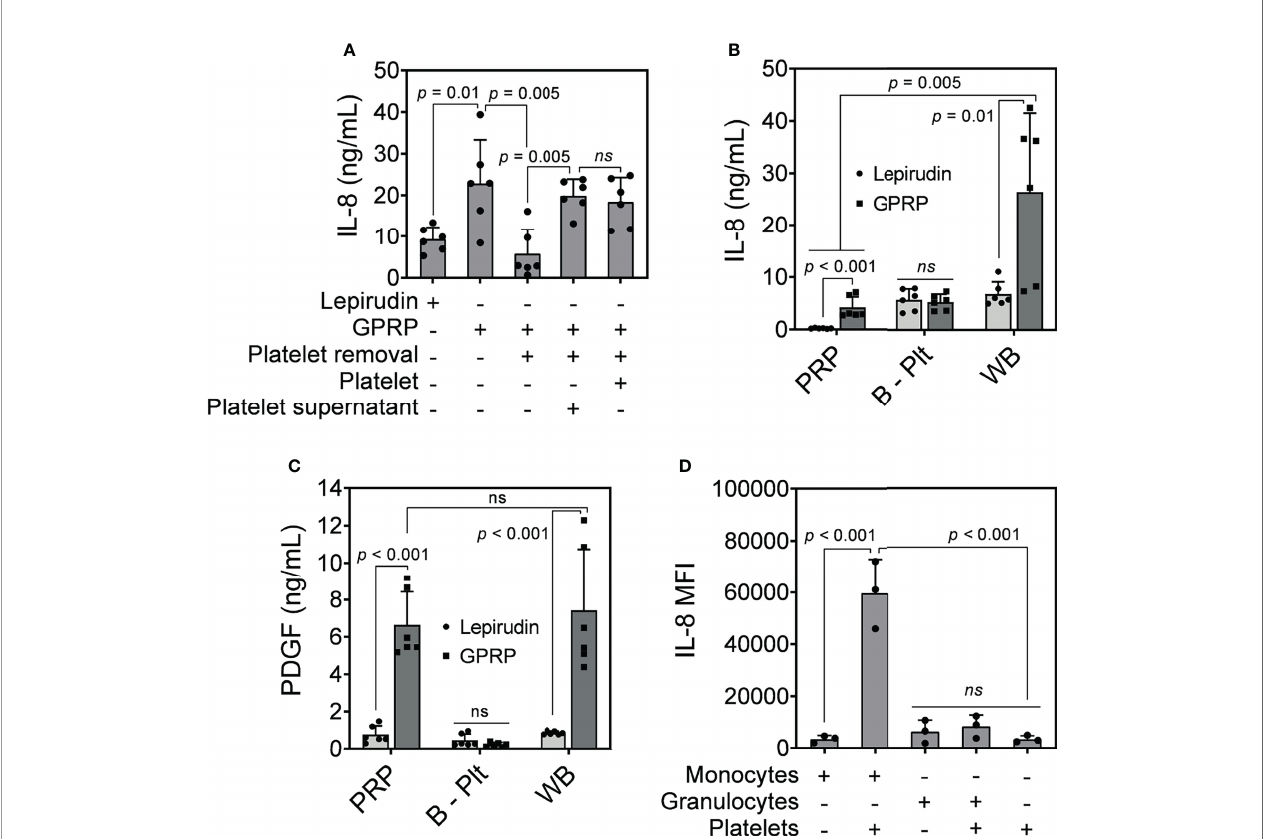
FIGURE 4 | IL-8 release in response to E. coli . (A) IL-8 was measured in GPRP-anticoagulated blood after incubation with E. coli (10 7 /ml) for 4 hours after the addition of Ca 2+ . The IL-8 levels were compared in whole blood, in platelet-depleted blood ( “ Platelet removal ” ), in platelet-plasma reconstituted ( “ Platelet ” ), and in reconstituted plasma supernatant from activated platelets ( “ Platelet supernatant ” ). (B) IL-8 and (C) PDGF measured in activated platelet-rich plasma (PRP), in platelet-depleted blood (B - Plt) and in whole blood (WB), all anticoagulated with either GPRP or lepirudin. Data are presented as mean ± standard deviation (SD) (n = 6). (D) Detection of intracellular IL-8 by fl ow cytometry in GPRP-anticoagulated blood. Data are presented as mean of median fl uorescence intensity (MFI) ± standard deviation (SD) from 3 blood donors with each dot representing average MFI of two replicates from each donor. ns, non signi fi